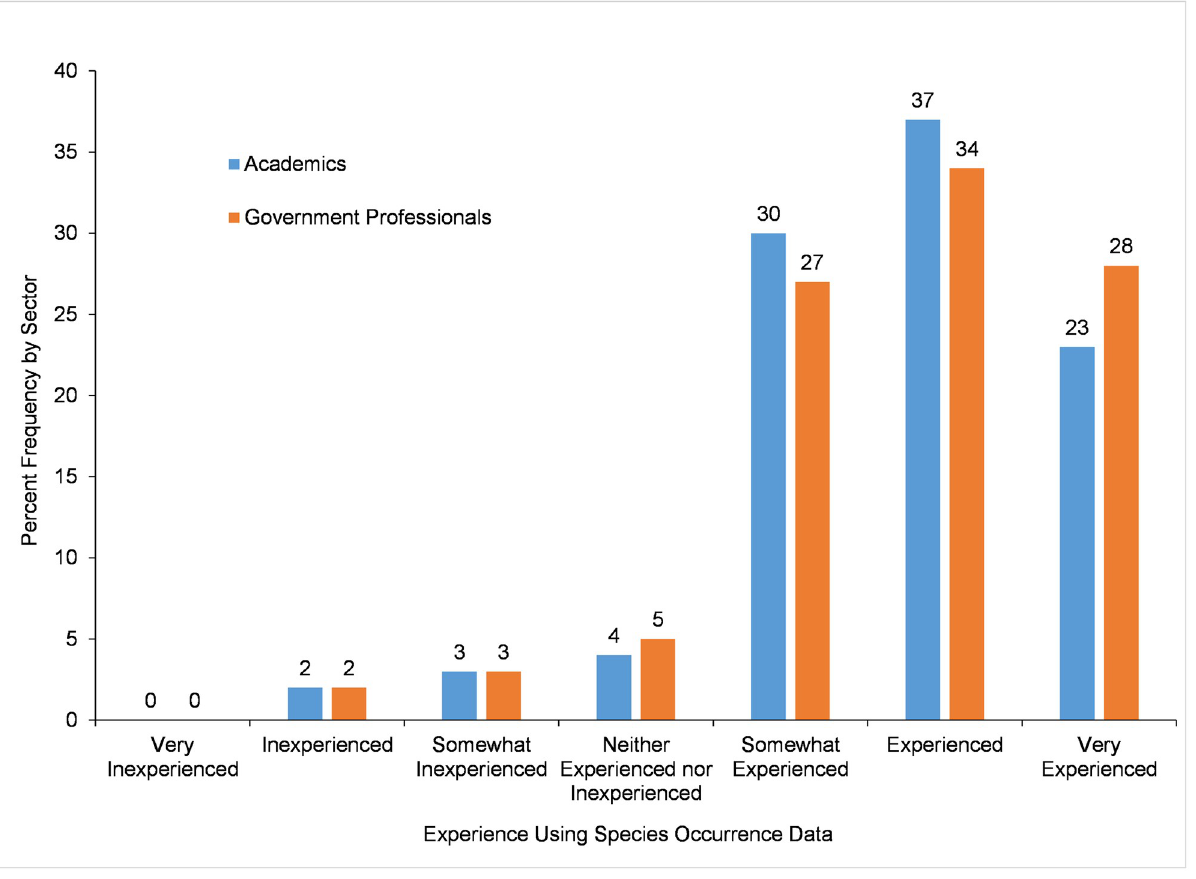
Fig 1. Level of experience using species occurrence